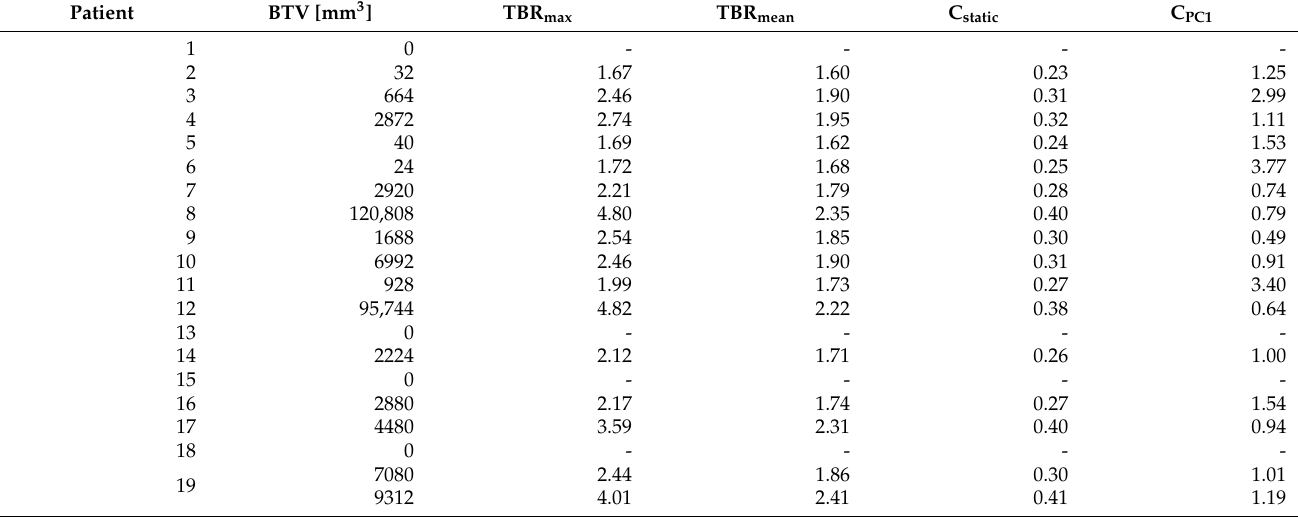
Table A3. Results of the PET data analysis. BTV: biological tumor volume, TBR max/mean : maximum/mean tumor-to- background ratio computed on the static PET image (20–27 min p.i.), C static/PC1 : tumor contrast computed on the static PET image/PC1